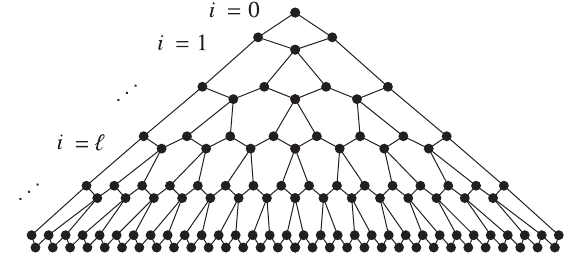
circle.FIG. 2. Tensor network representation of the QCNN. Here each unitary W in the convolutional and fully connected layers forms ij a 2-design. The operators I of Eq. (7) in the pooling layer do not ij modify the variance Var ½ ∂ μ C (cid:2) as their action can be absorbed by the action of the unitaries in the convolutional layers. Each tensor (circle) corresponds to a W , with L ¼ 0 corresponding to the ij unitary in the fully connected layer. Circle with three legs indicates that a qubit is traced out after their